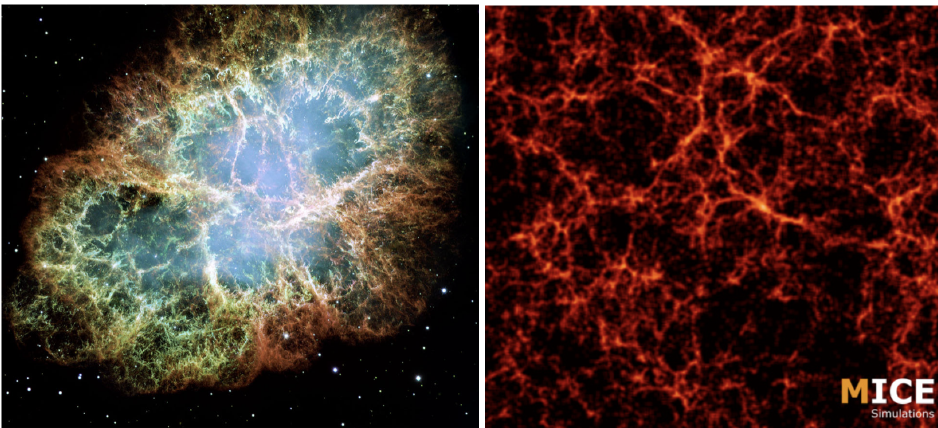
Figure 5. ( Left ): The Crab Nebula explosion as observed in 1999 from the Hubble Space Telescope, 945 years after it exploded. A pulsar remnant could be part of the Dark Matter. ( Right ): the MICE simulation [74] of our expanding Universe. The resulting structures are related in the Big Bounce